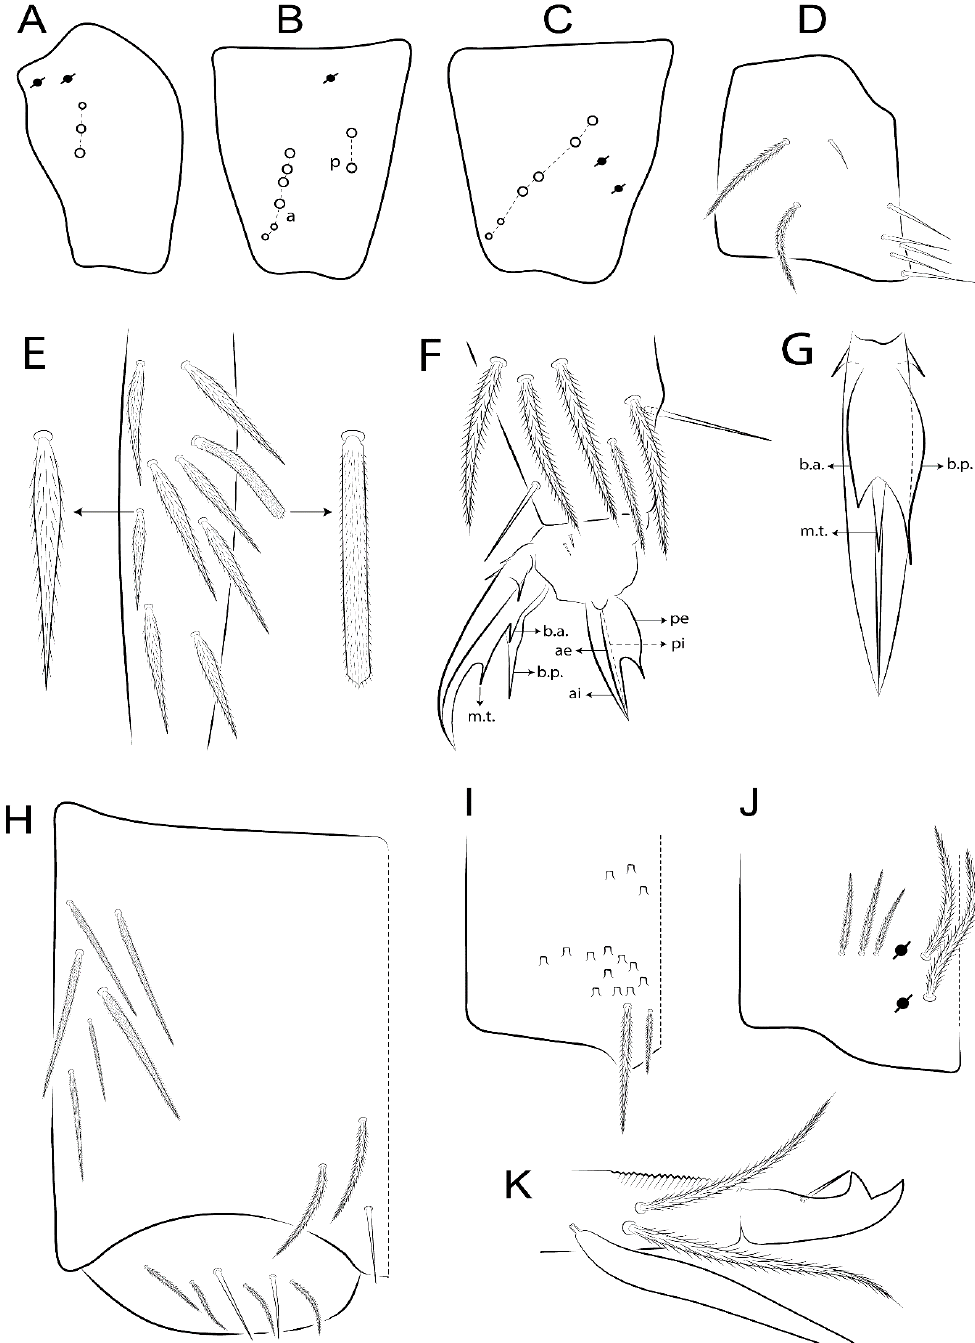
Figure 15. Pseudosinella brumadinhoensis sp. nov.: trunk appendages. ( A – C ) subcoxa I–III, respectively; ( D ) trochanteral organ; ( E ) tibiotarsus II median part (inner view), arrow indicates scale-like chaeta and modified chaetae, respectively; ( F ) distal tibiotarsus and empodial complex III (anterior view); ( G ) unguis (inner view); ( H ) collophore (lateral view); ( I ) distal part of manubrium (ventral view); ( J ) manubrial plate (dorsal view); ( K ) distal dens and mucro (outer view).